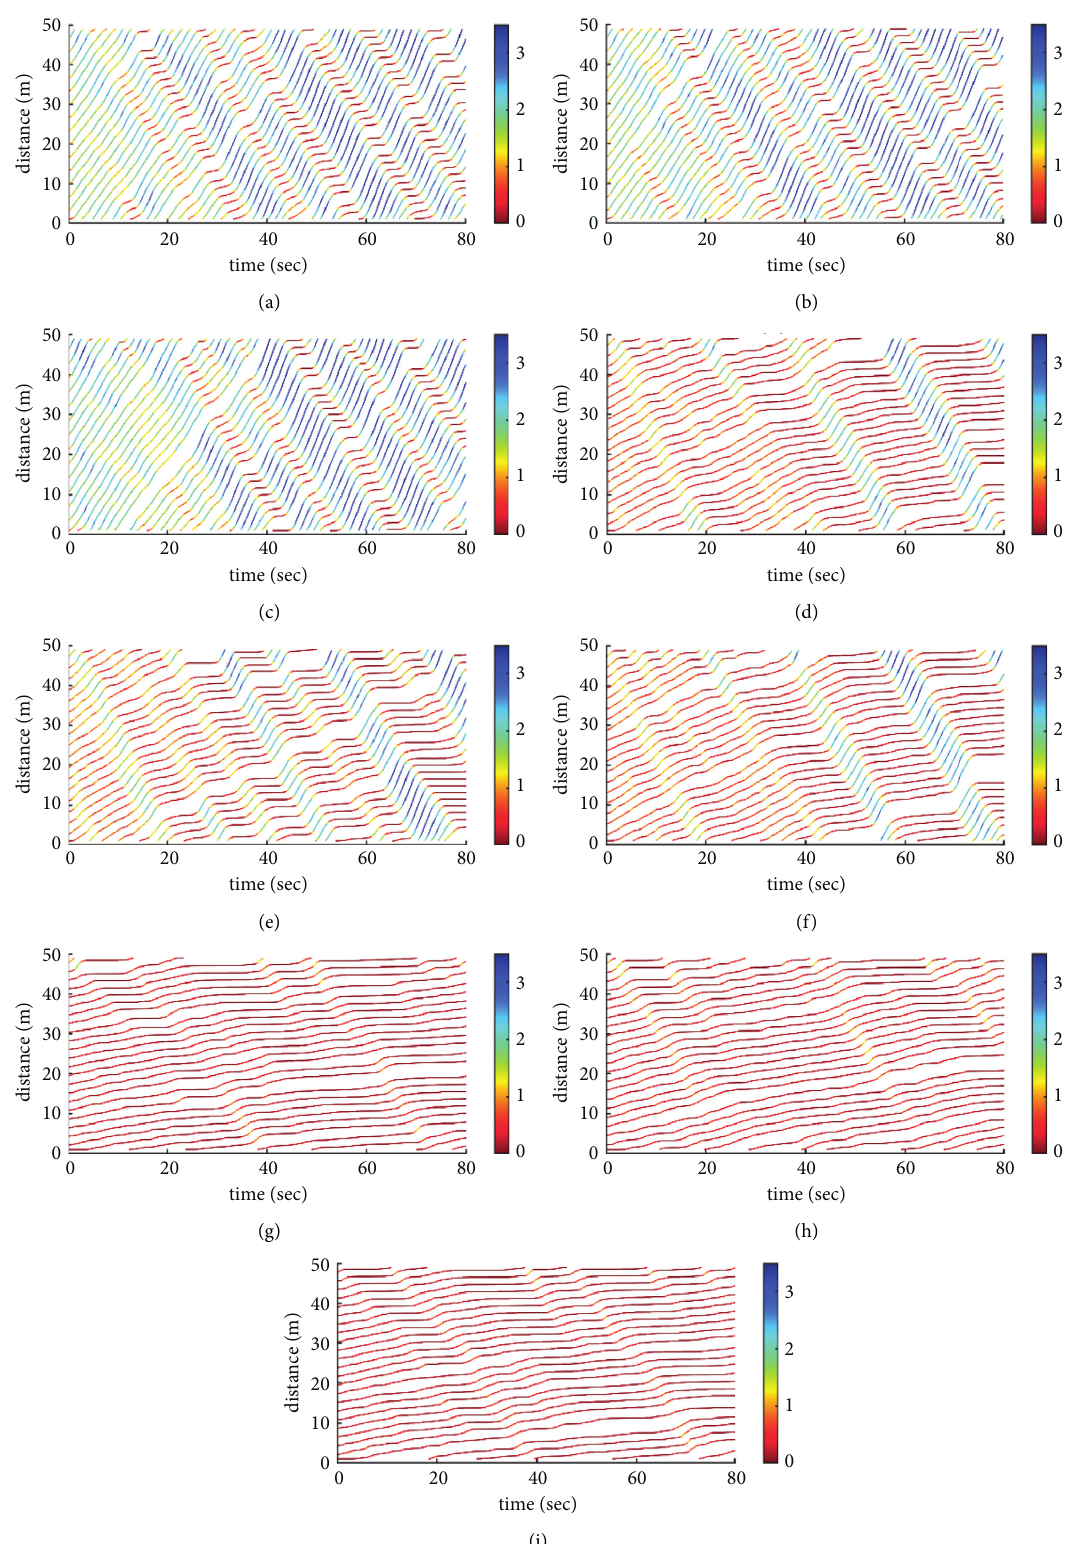
Figure 6: Each bicycle’s trajectory in Case II under different N . (a–c) Left lane, (d–f) middle lane, and (g–i) right lane. (a) N � 15. (b) N � 15. (c) N � 15. (d) N � 19. (e) N � 19. (f) N � 19. (g) N � 23. (h) N � 23. (i) N �